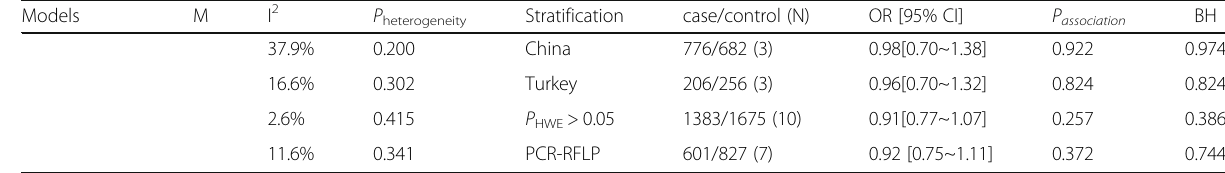
Table 5 Pooled analyses of the association between VDR rs731236 polymorphism and susceptibility to psoriasis (Continued) Models